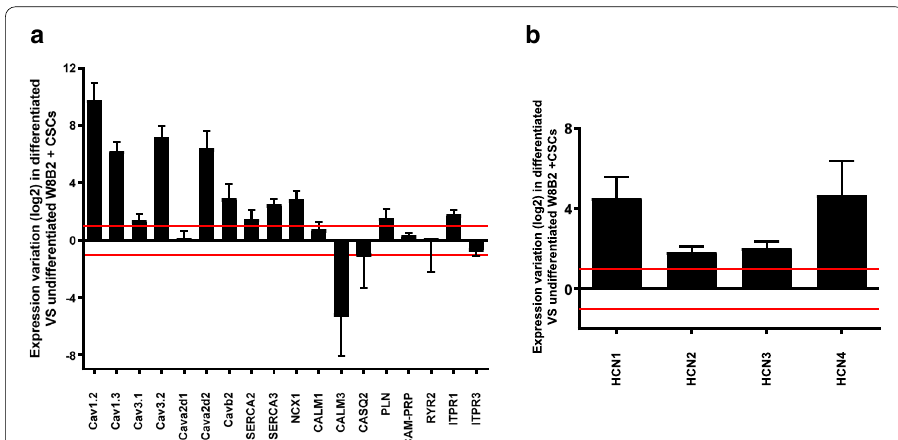
Fig. 3 Effect of W8B2 + CSC in vitro differentiation on calcium channels, ion exchangers and contributors to calcium homeostasis. Transcript coding for players in the process of calcium homeostasis analyzed by TLDA in differentiated vs undifferentiated W8B2 + CSCs. Graphs illustrate gene expression variations (in log 2) of differentiated cells versus undifferentiated cells from N 4 patients. Horizontal red lines correspond to 1 and = 1 −